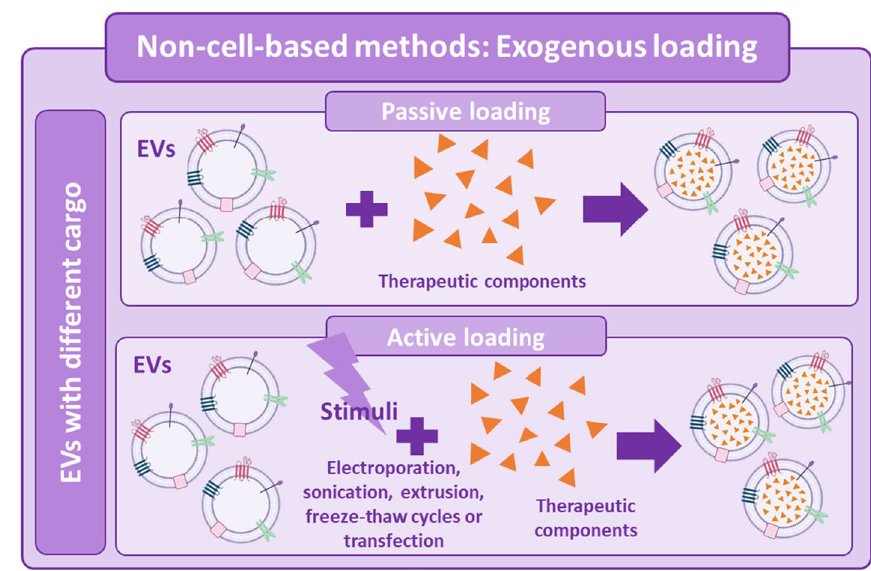
Fig. 1 Non‑cell‑based methods for the modification of EVs cargo. EVs extracellular